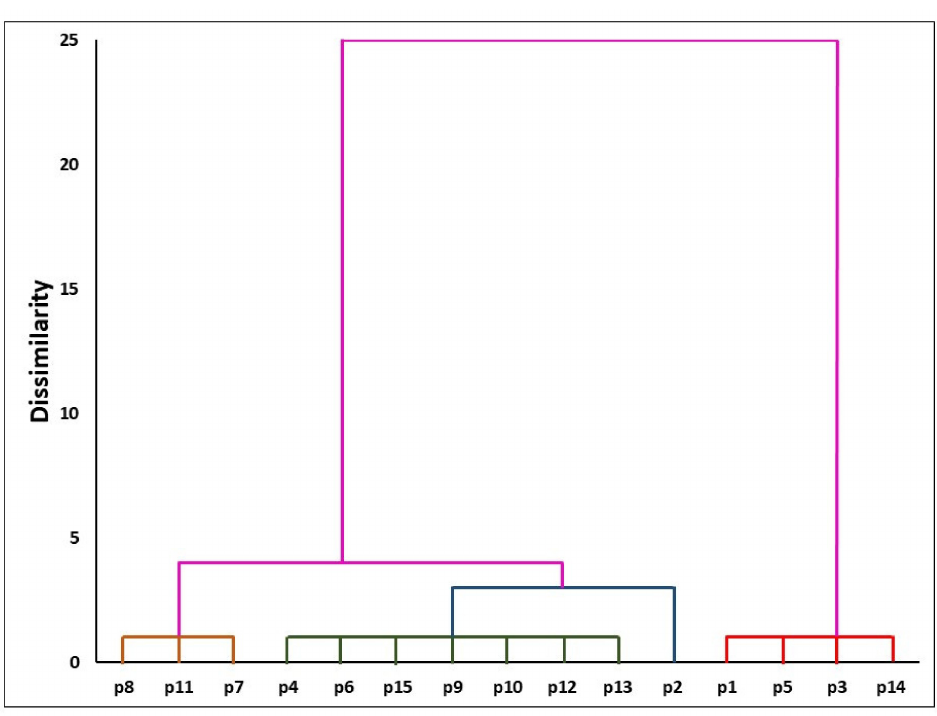
The cluster analysis revealed two dissimilar clusters based on PC scores. A dendrogram showing hierarchical clustering of the four groups based on soil properties was obtained, with